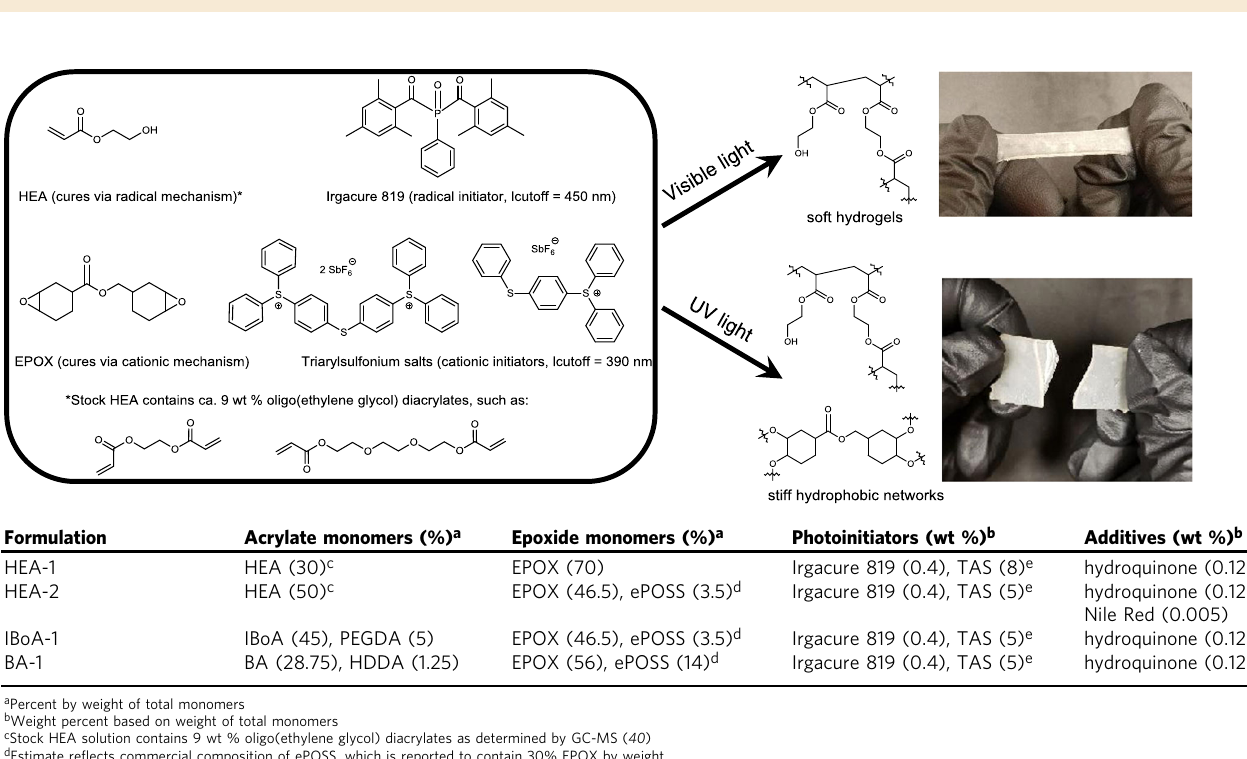
Table 1 (Top) Idealized representation of using the HEA-1 MASC formulation to achieve different materials with different wavelengths of light. (Bottom) MASC formulations used in this